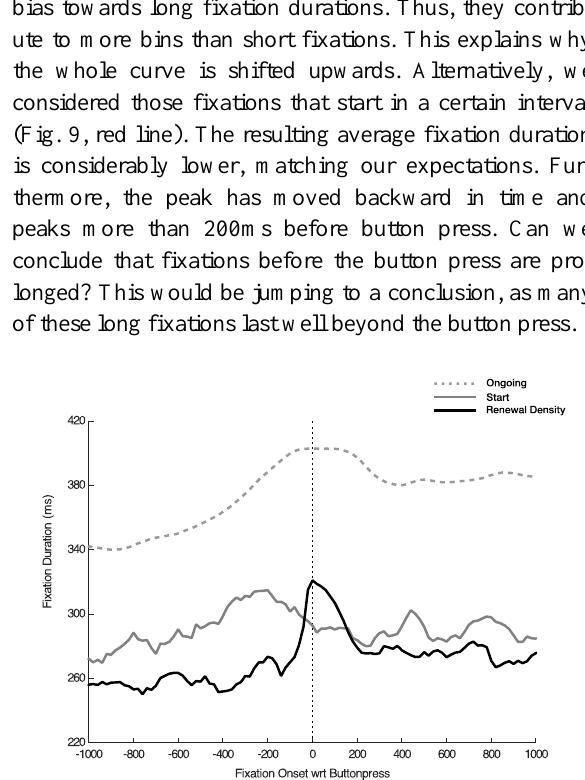
Figure 8. Probability distribution of saccadic amplitudes during free exploration of images of various sizes. The red and black lines show data for the 7” and 30” conditions respectively. The blue lines gives the model prediction for the 7” condition based on the 30” data (for details see text). The dashed lines indicate the median.